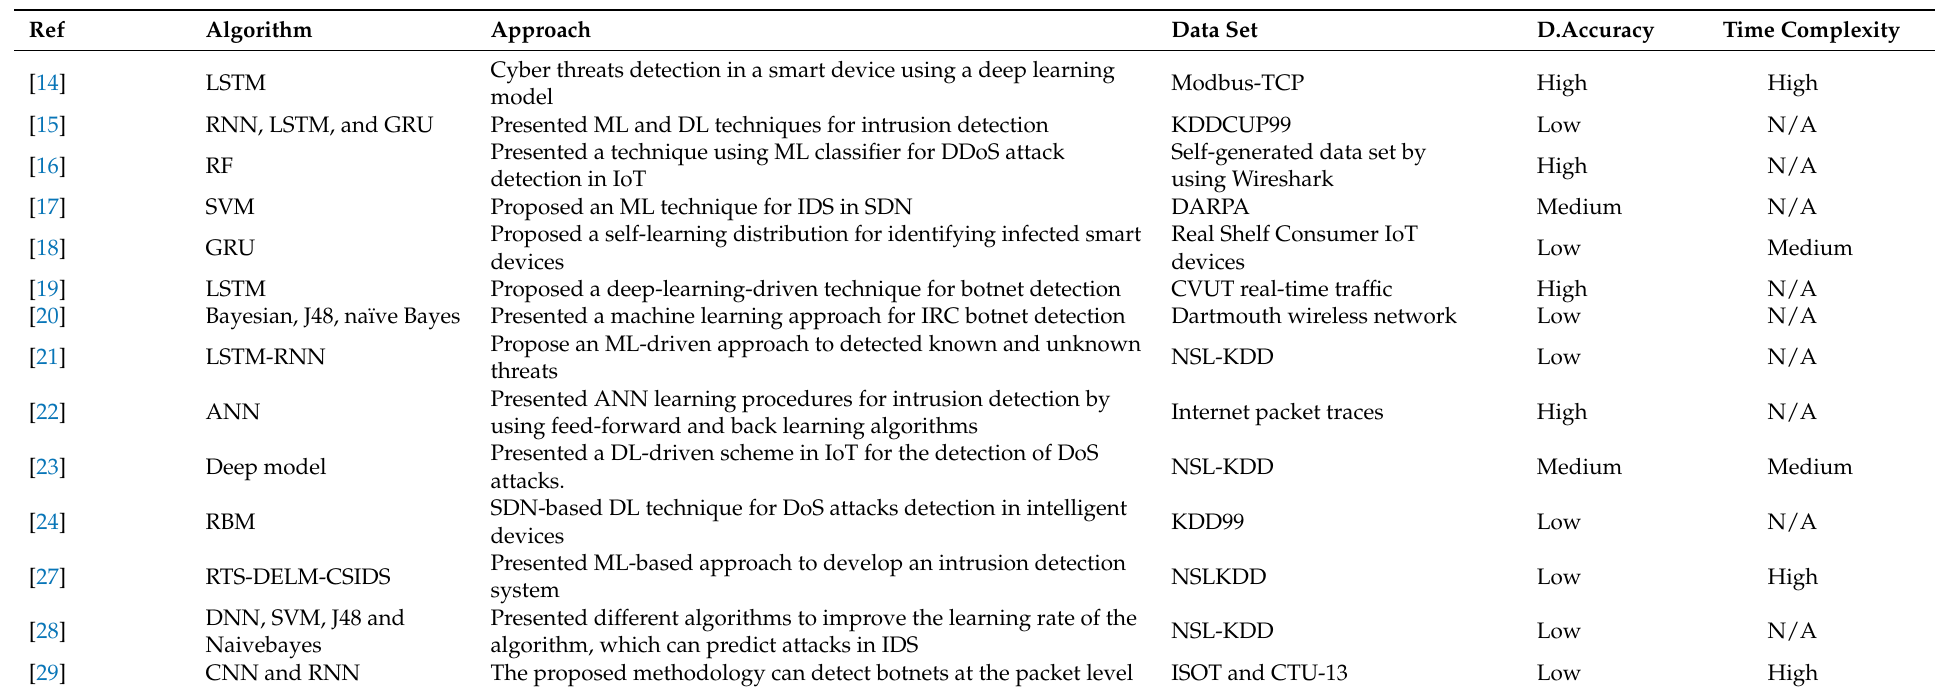
Table 1. Comparison of existing